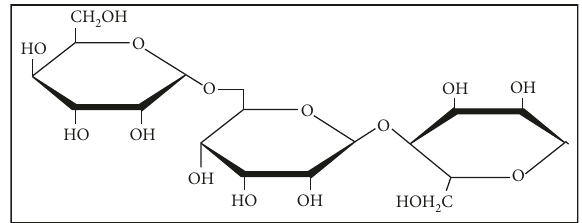
Figure 2: Molecular structures of